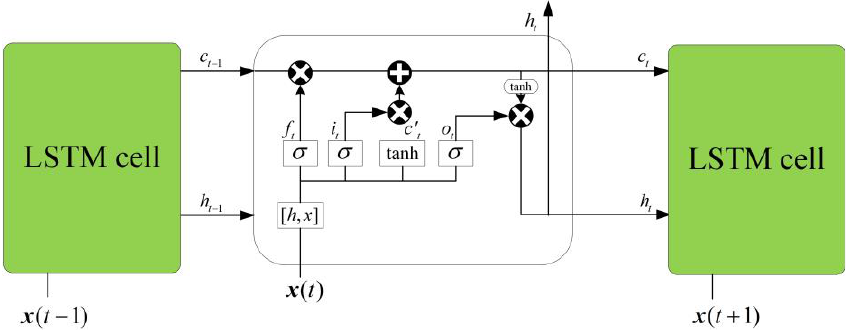
Figure 5. Schematic diagram of LSTM internal